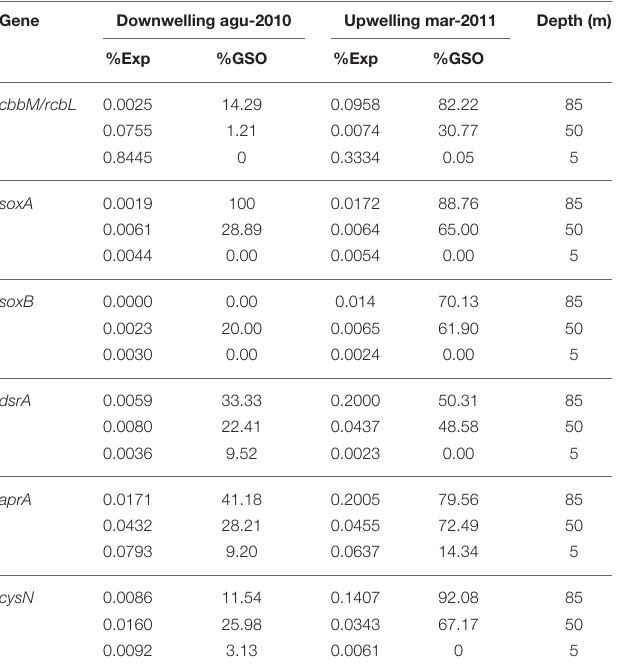
TABLE 3 | Percentage of relative expression for key genes in nitrogen cycle and their taxonomic affiliation to GSO group.